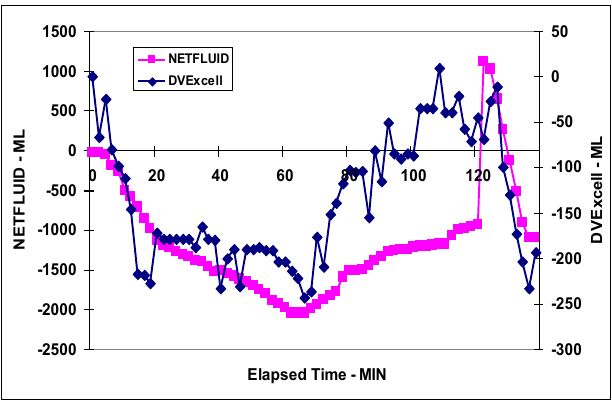
Fig. 3: Changes in NETFLUID and leg DVExcell vs elapsed